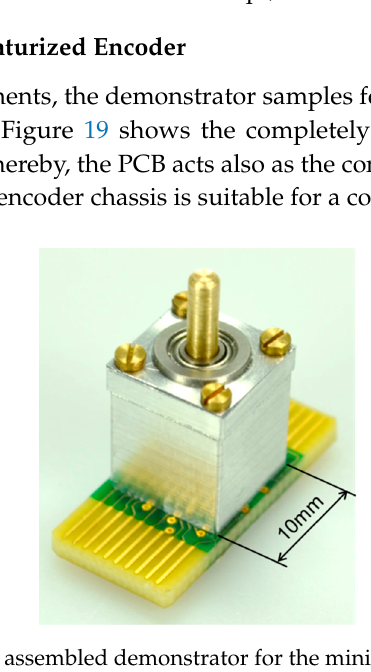
Figure 20. Example of the Gray code encoder signals (bit 6) for one revolution (360°). To analyze the performance of the Gray code encoder, the diagram in Figure 20 shows the differential signals over a small angular range. Displayed are all 10 tracks from bit 0 to bit 9, whereby bit 0 is the bit with the finest scale and, therefore, has the most oscillations. It can be seen that all bits delivered the correct signals and that they could be digitized at a constant threshold, for example, at 0 V. Furthermore, it can be seen that the signals were still not perfect because a drift could be observed during rotation of the encoder disc. This effect could probably be improved after a design review of the system with a better assembly process of the lens, whereby the optical system could maybe be improved in respect of a more tolerant optical path.